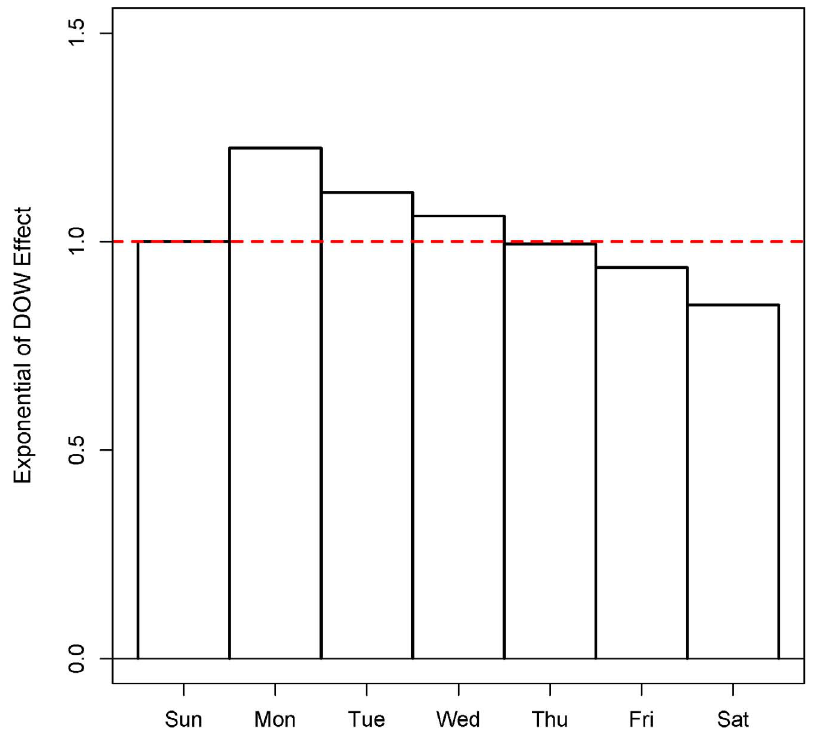
Figure 9. Exponential of Day-of-week effect estimated by MGAM.